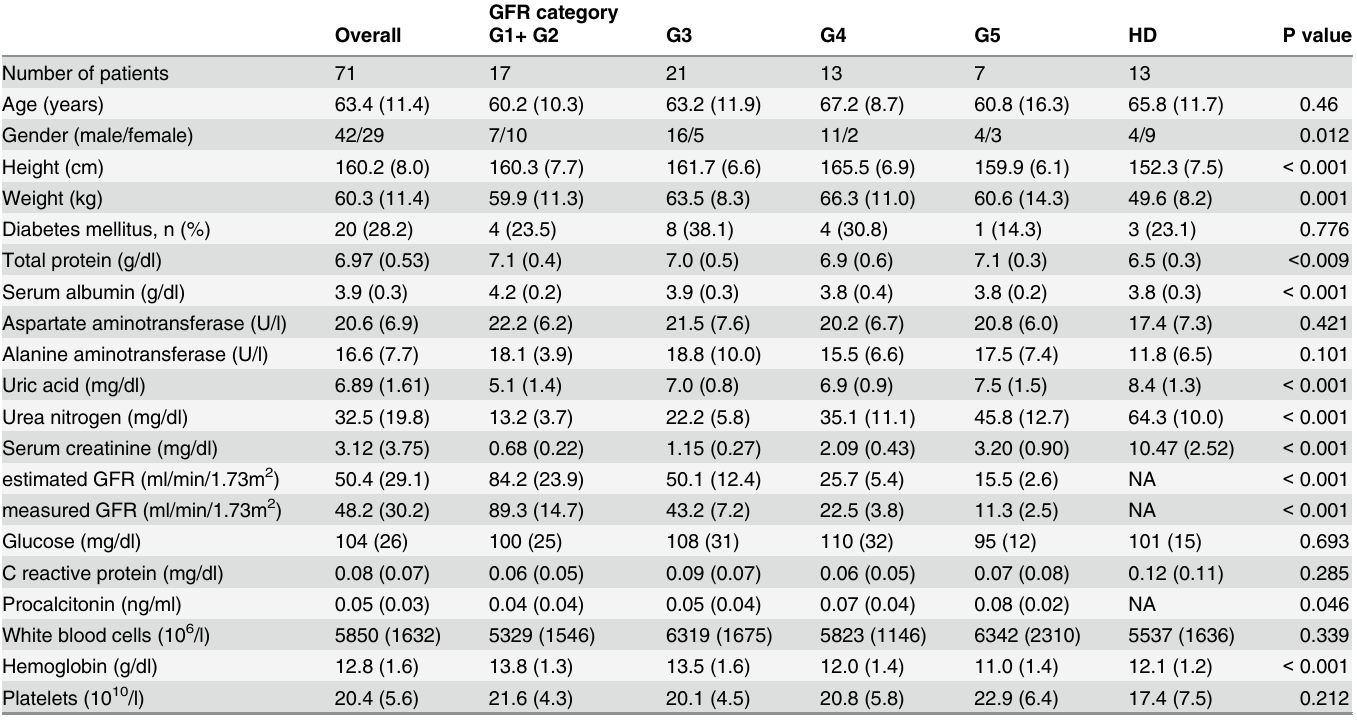
Table 1. Clinical characteristics of the study participants and comparison of patients in the different GFR categories or receiving